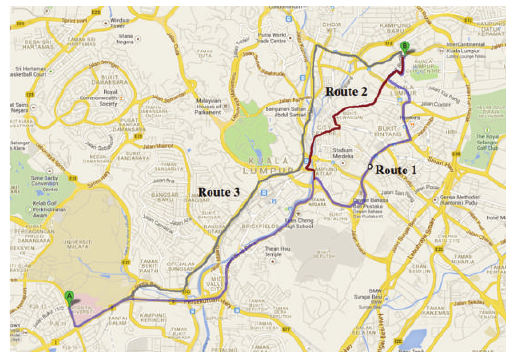
Figure 7: Three different routes of the same origin and destination.